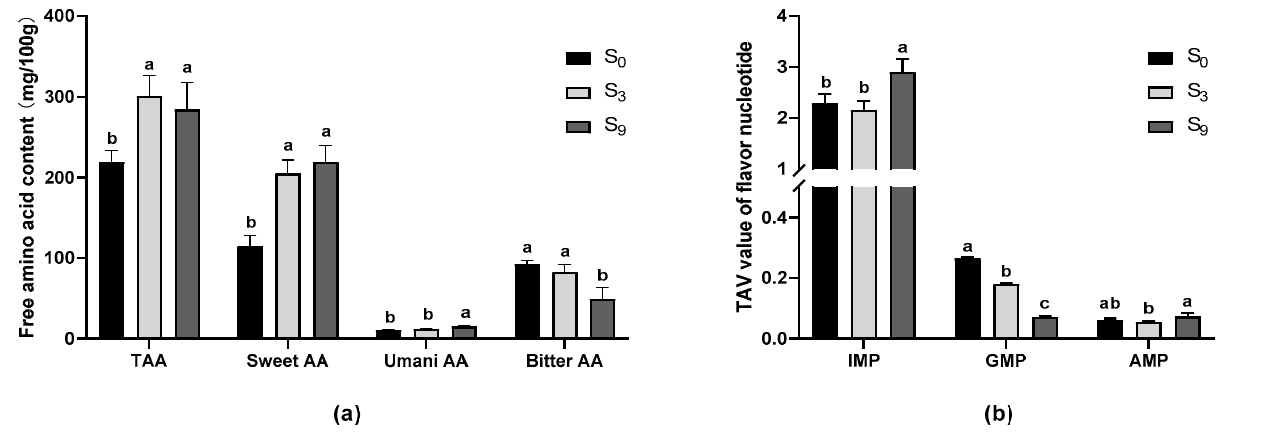
Figure 3. Effects of salinity on the the content of flavor substances in largemouth bass muscle. ( a ) The contents of free amino acid; ( b ) the content of flavor nucleotide. TAA is total free amino acid, Sweet AA is sweet amino acid, Umani AA is umani amino acid, and Bitter AA is bitter amino acid. Bars with different letters (a, b) are significantly different ( p < 0.05; Tukey’s test) between the two groups.